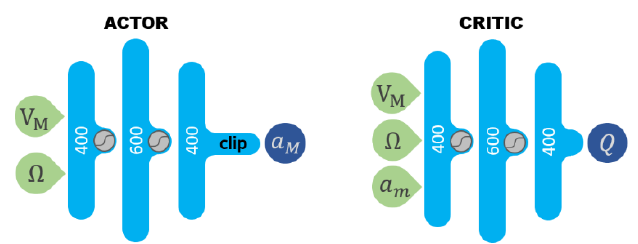
is the hyperbolic tangent activation function.